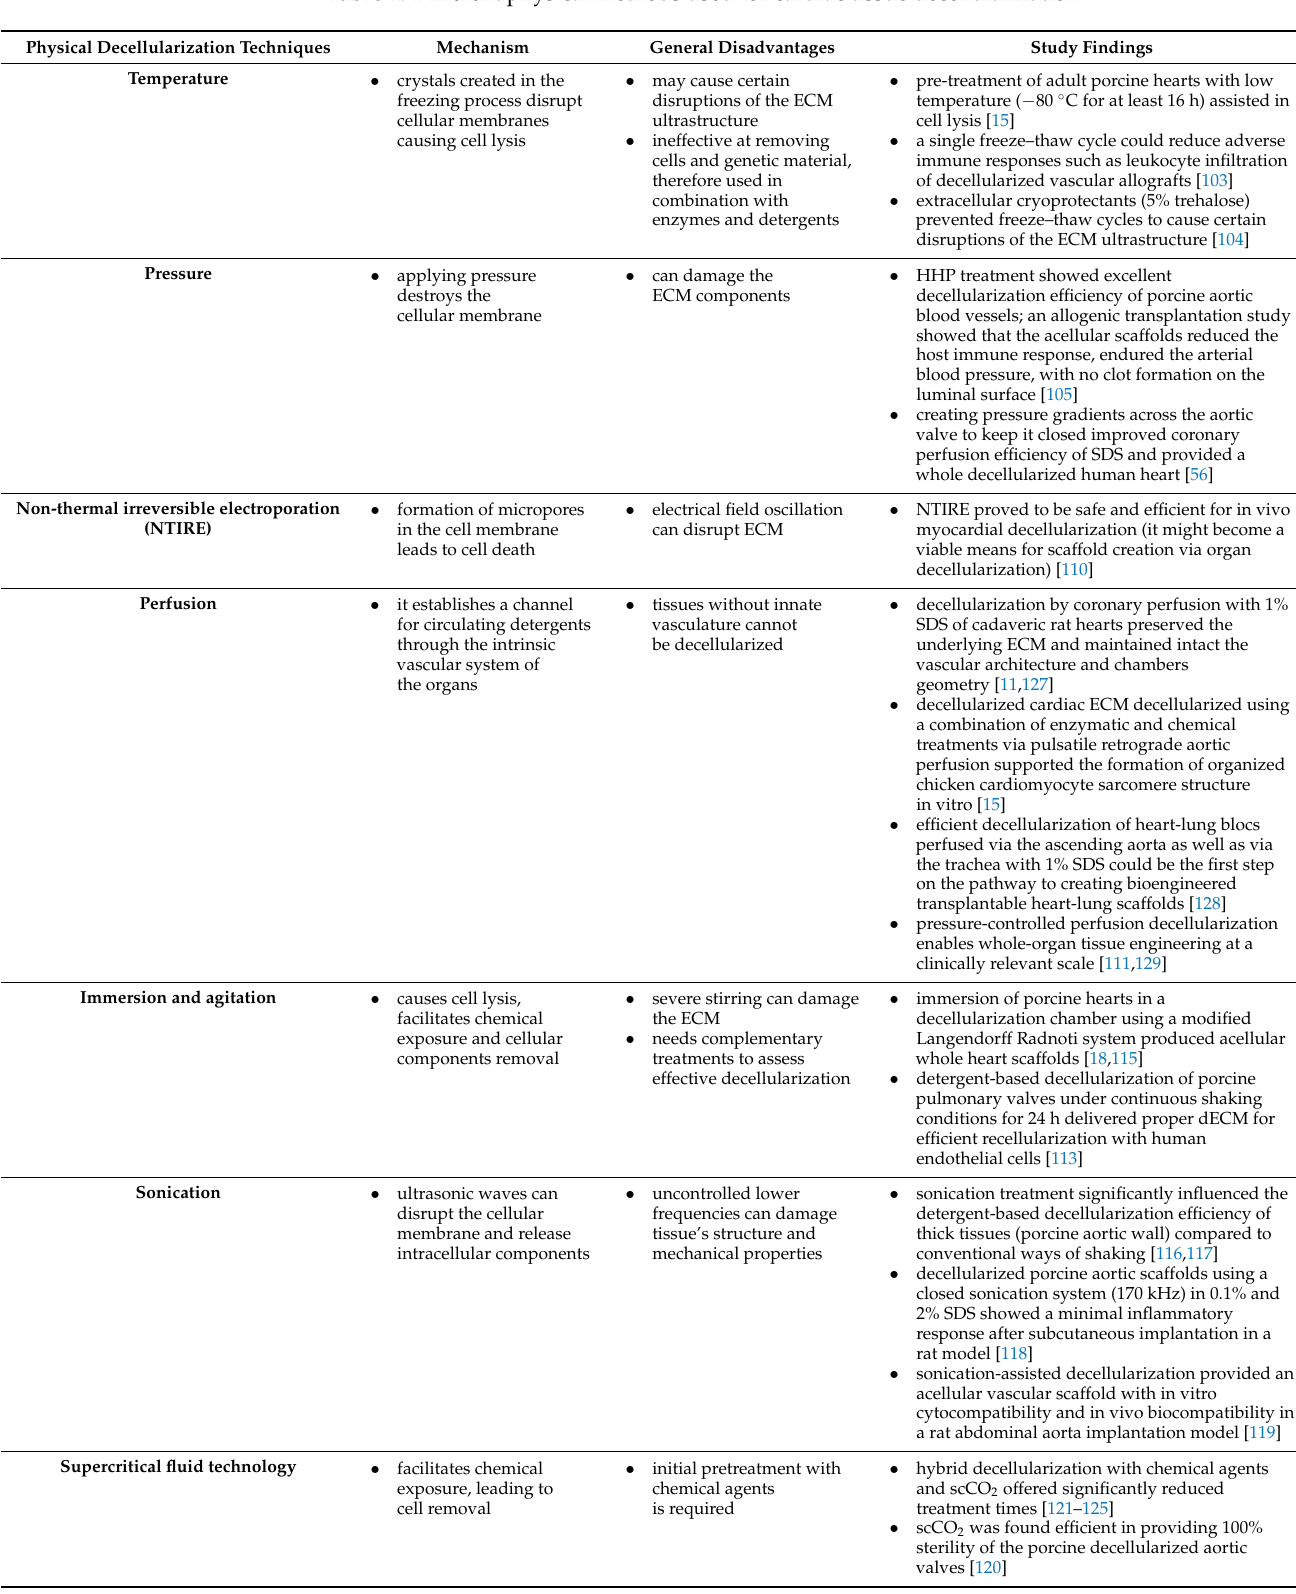
Table 4. Different physical methods used for cardiac tissue